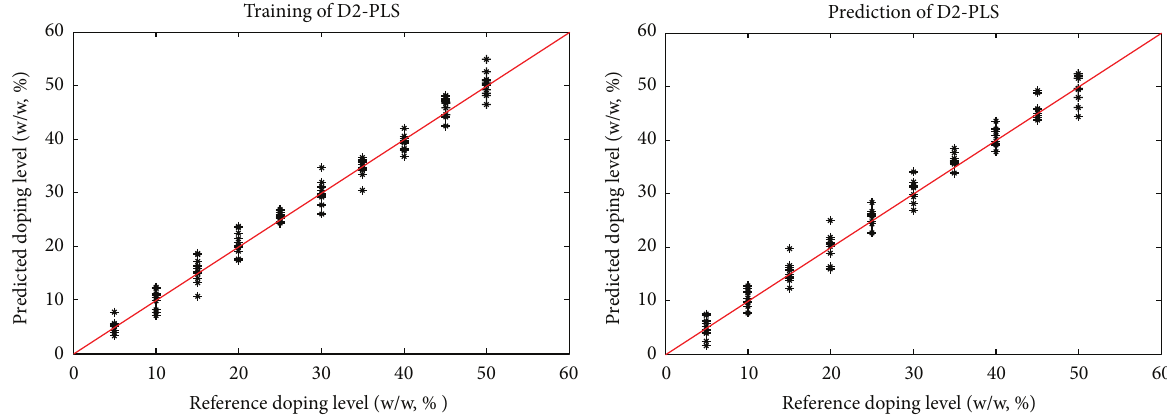
Figure 3: The training and prediction of contents of wheat flour in oat flour by three-component D2-PLS.